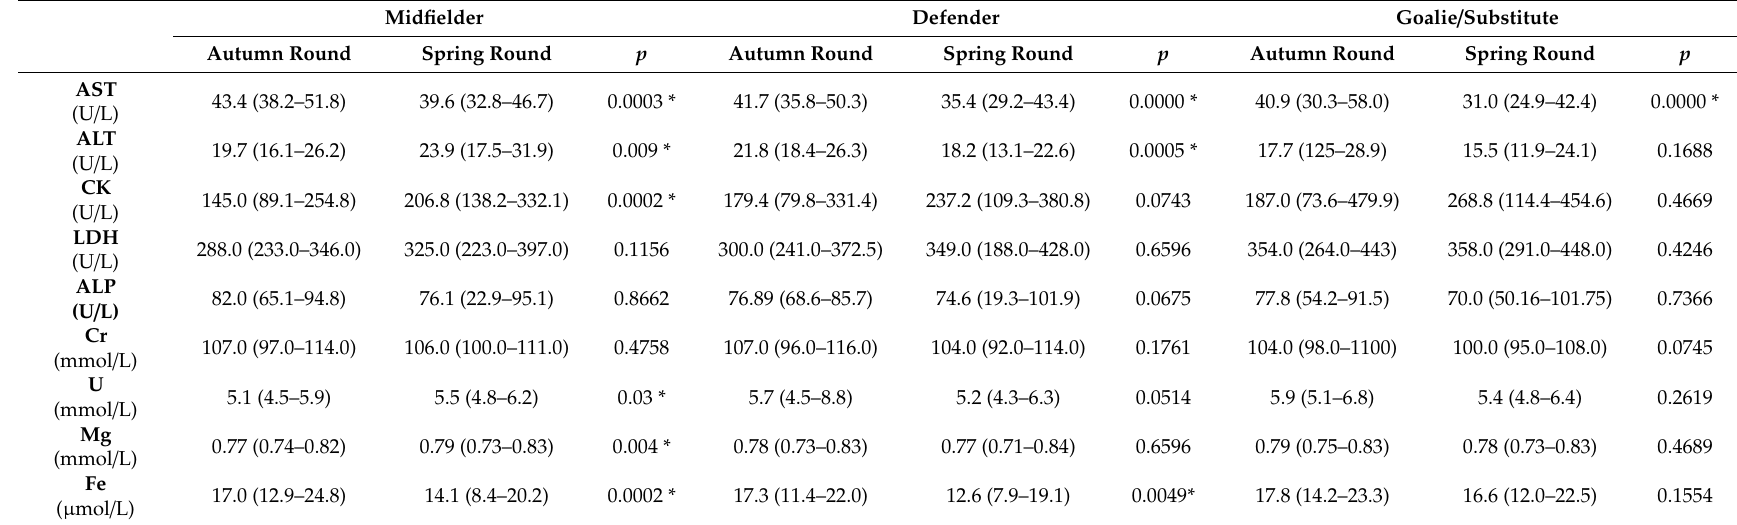
Table 5. Comparison of the midfielder, defender and goalie / substitute subgroups in terms of selected plasma biomarkers values during the autumn and spring match rounds.